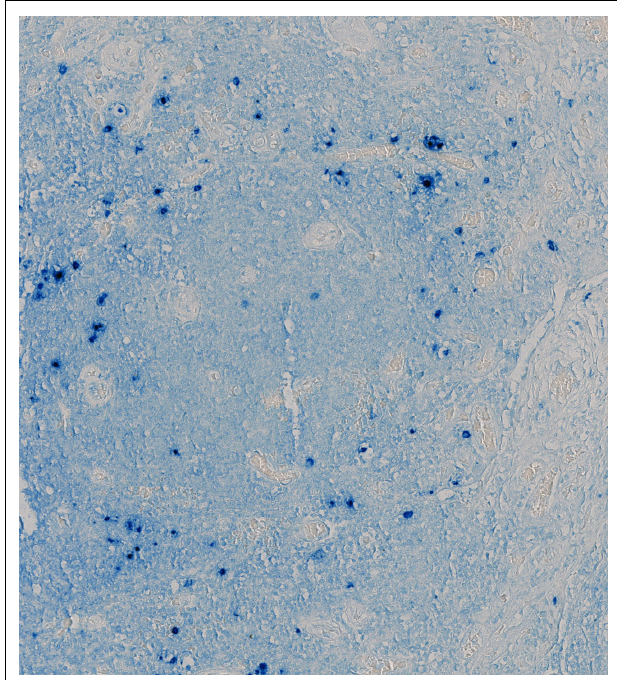
FIGURE 1 | Lymph Node from a Patient with KSHV–MCD Stained for vIL-6. Germinal center of a lymph node from a patient with KSHV–MCD, stained with a monoclonal antibody to vIL-6 and an alkaline phosphatase substrate. Cells expressing vIL-6 stain in blue; these cells are located primarily in the mantle region around the germinal center.The tissue was studied under a protocol approved by the Institutional Review Board of the National Cancer Institute, and the patient gave written informed consent.